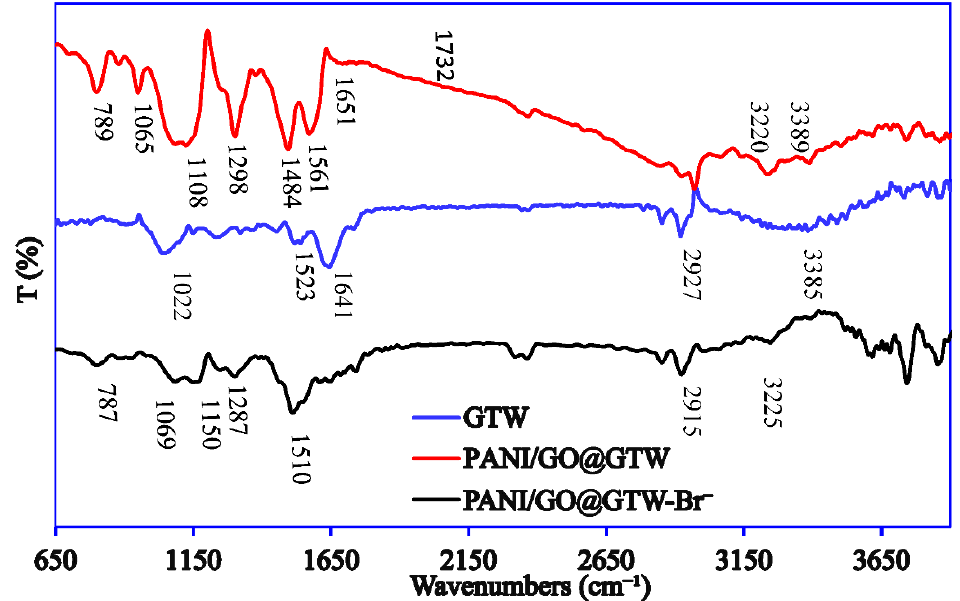
Figure 5. FTIR spectrum of GTW, PANI/GO@GTW, and Br − adsorbed PANI/GO@GTW.